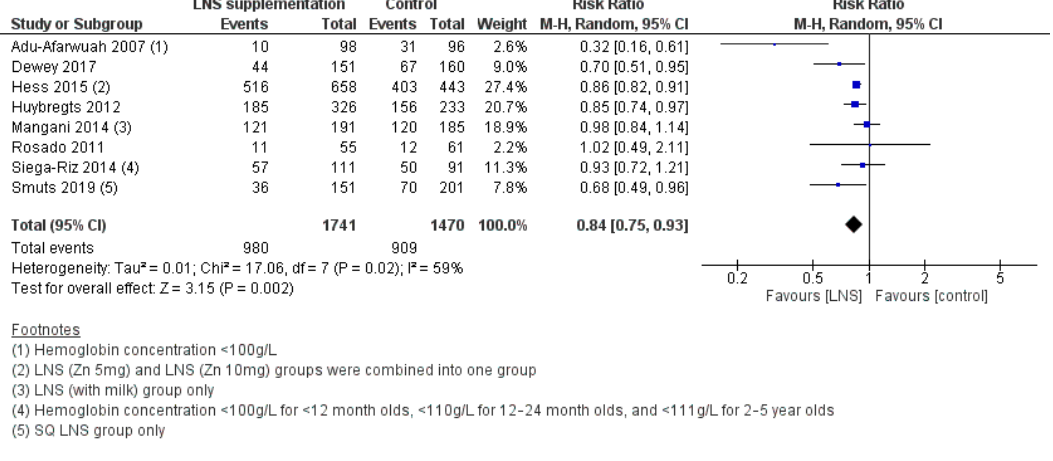
Figure 6. LNS supplementation versus placebo/no intervention (efficacy studies) on the risk of anemia (hemoglobin concentration < 110 g/L).